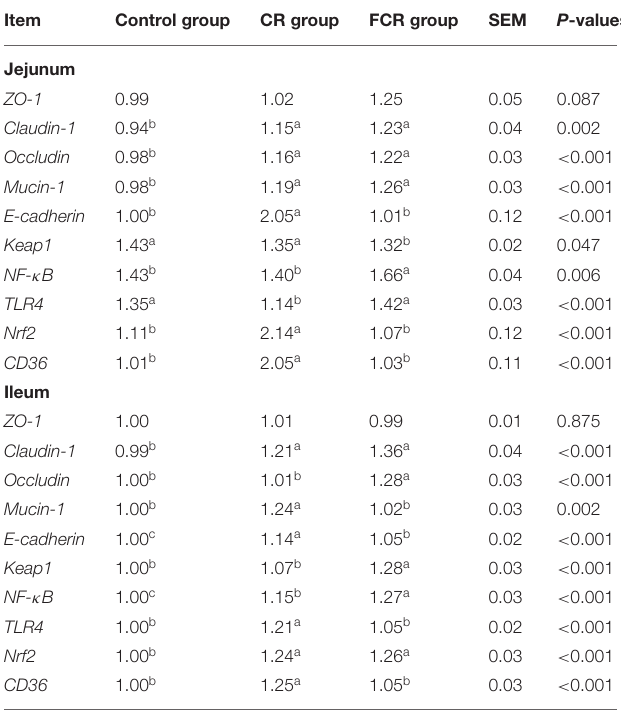
TABLE 5 | Effects of cassava residue (CR) or fermented cassava residue (FCR) on gut barrier function-related gene expressions of piglets. Item Control group FCR